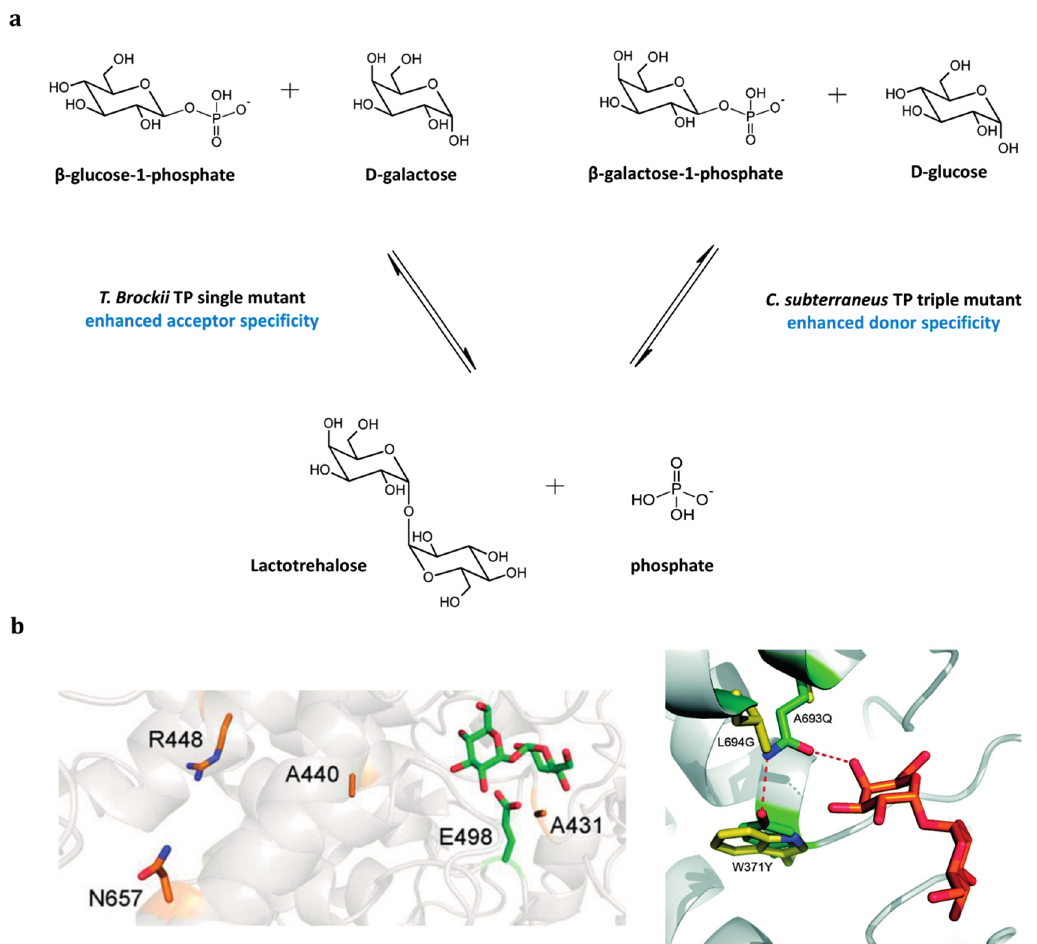
Figure 6. Enhancing acceptor and donor specificity of T. brockii trehalose phosphorylases (TP) and C. subterraneus TP via random mutagenesis and rational design, respectively. ( a ) Reversible conversions of β -Glc-1P with D -galactose and β -Gal-1P with D -glucose into lactotrehalose, catalyzed by the T. brockii TP-single mutant (R448S) with enhanced acceptor specificity, and the C. subterraneus TP-triple mutant (L694G/A693Q/W371Y) with enhanced donor specificity, respectively; ( b ) Active sites of T. brockii TP ( left ) and C. subterraneus TP ( right ) with the positions subjected to mutagenesis indicated. For T. brockii TP, the mutated R448-residue is shown in orange/blue amongst other mutated residues from the same study, and the trehalose substrate with the catalytic residue (E498) in green. In the C. subterraneus TP active site, the three mutagenized positions (L694G/A693Q/W371Y) causing a switch in donor specificity are indicated in green with the corresponding wild-type residues shown in yellow. The lactotrehalose substrate is indicated in orange